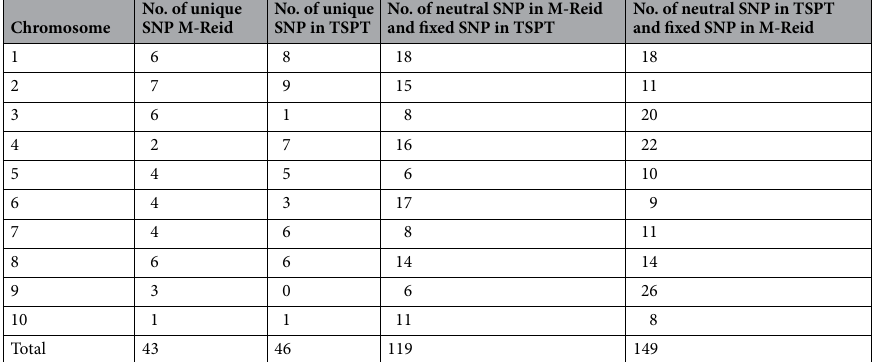
Table 2. Number of unique, neutral or fixed SNP loci in M-Reid and TSPT group.